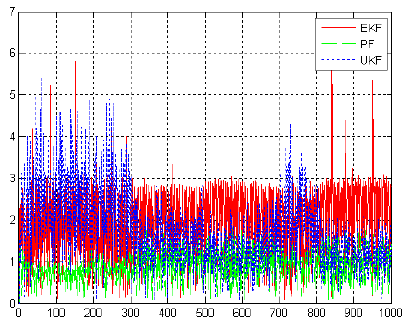
Figure5. X direction positioning error comparison under three kinds of filter